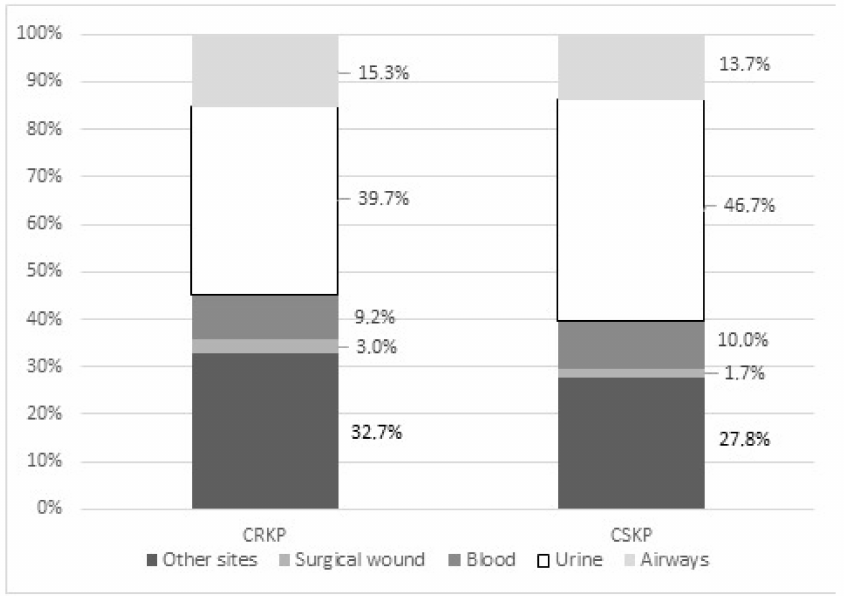
Figure 2. Distribution of sampling sites in carbapenem-resistant (CRKP) versus carbapenem sensitive Klebsiella pneumoniae (CSKP) strains. (Marches region, Italy,